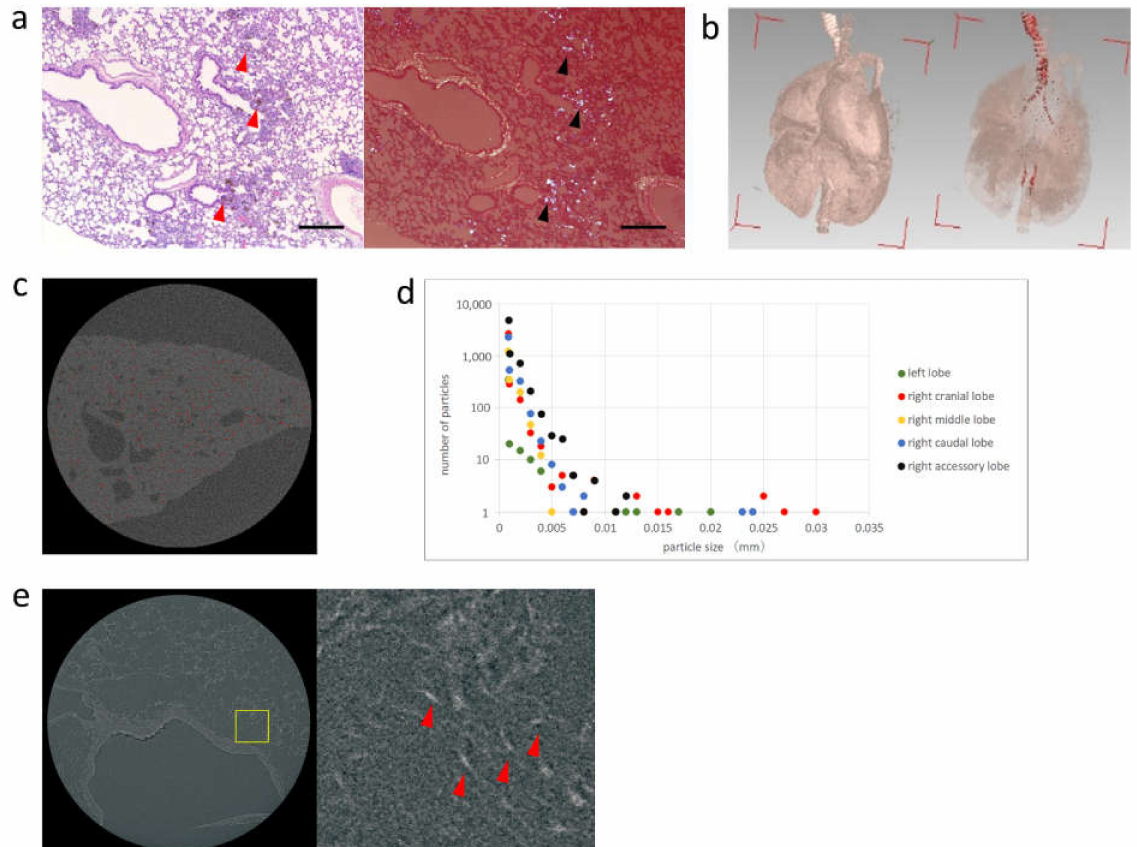
Figure 4. Histological image of the removed lung and X-ray image: ( a ) Light microscopy (left) and polarization microscopy (right) at 1 week after intratracheal administration of Pt-peapods. Pt-peapods were deposited from the main bronchus to the peripheral bronchi. Hematoxylin-Eosin Stain. Scale bar: 300 µ m. ( b ) Diagrams for 3D configuration (left) and high absorber detection (right) of 3D micro X-ray CT scanning. A large number of highly absorptive substances in the lung (red dot: minimum of approximately 100 µ m 3 ) were confirmed from around the tracheal bifurcation to the pulmonary lobe. ( c ) Red point indicates the point of measurement in the 3D micro X-ray CT image of the right lobe. ( d ) The number of particles in each pulmonary lobe after 1 week of intratracheal administration. ( e ) An image (left) of a tissue section of the lung at 1 week after administration of Pt-peapods taken by 3D X-ray microscopy, and an enlarged image in the yellow frame. Pulmonary alveolus was visualized and Pt-peapods as small as approximately 1 µ m could be